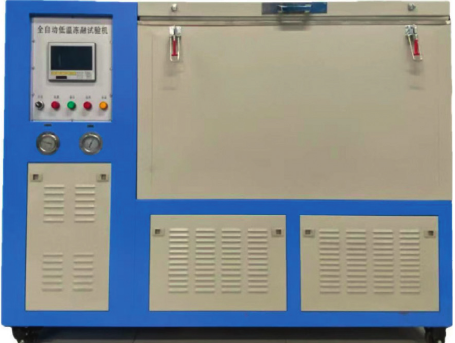
Figure 3: Concrete rapid freezing and thawing test machine.